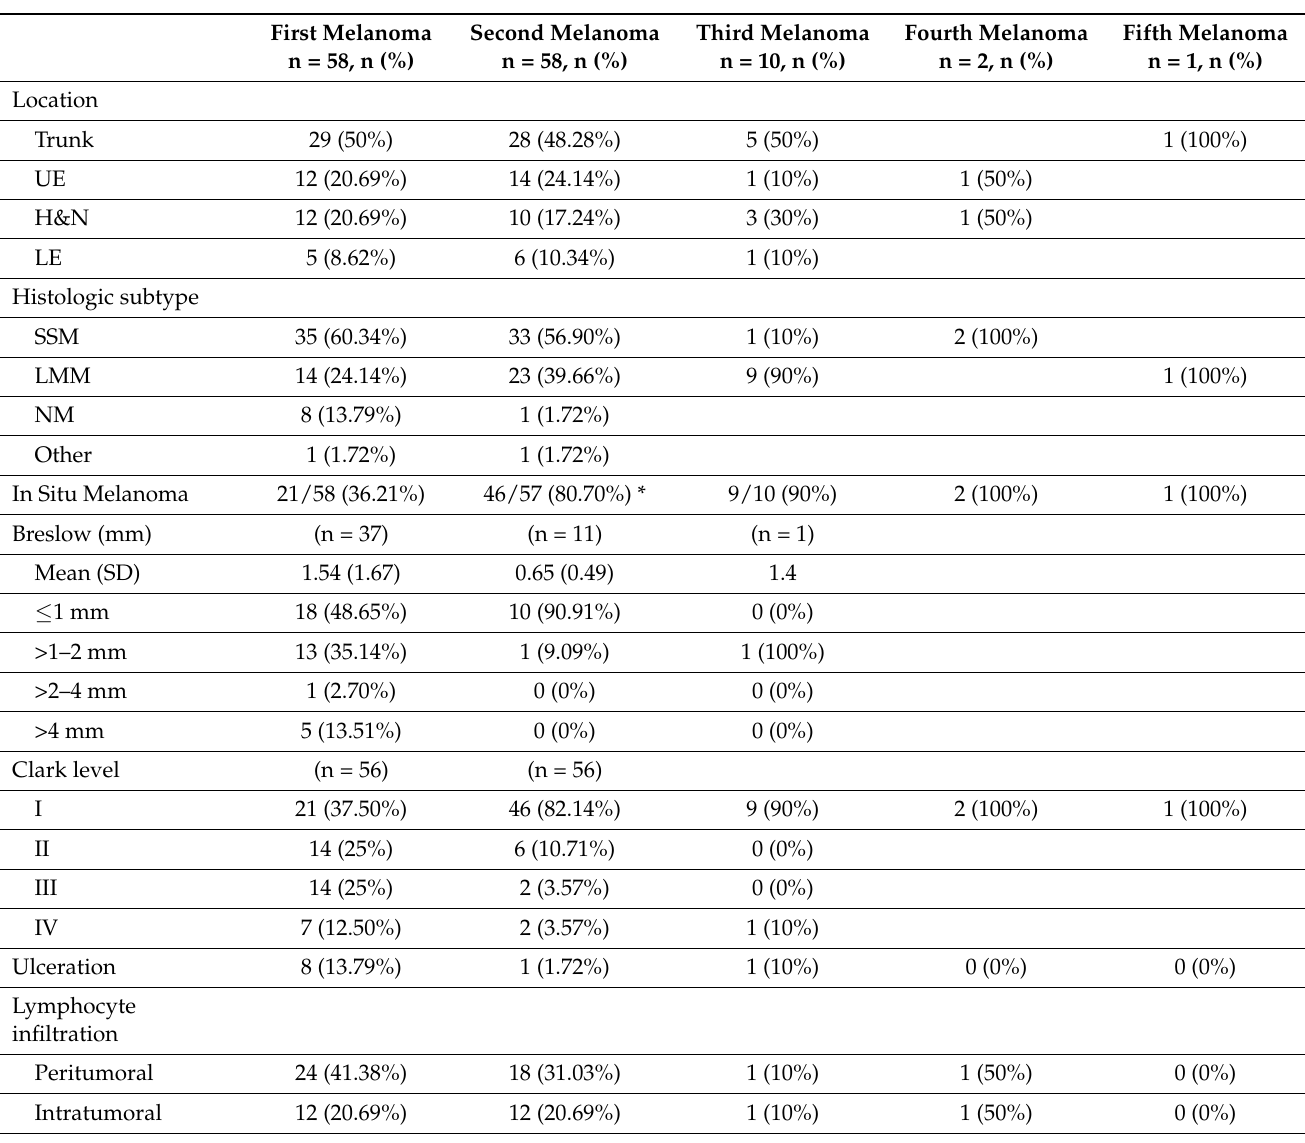
Table 2. Clinical and histopathological characteristics of multiple primary